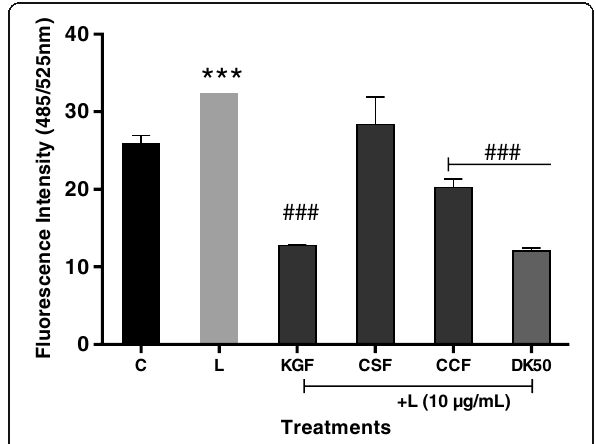
Fig. 2 Inhibition of LPS toxicity on U87 cell lines by various polysaccharide fractions and diclofenac potassium; ( a ) C-control cells; L-LPS (100 μ g/mL), KGF, CSF, CCF polysaccharides of Khaya grandifoliola stem bark, Cryptolepis sanguinolenta and Cymbopogon citratus leaves were tested at 100 μ g/mL and Diclofenac potassium at 50 μ g/mL (DK50). Data are expressed as mean±SEM, *** denote statistical signifi- cance p <0.001 in comparison to the control group; ( b ) KGF, CSF, CCF polysaccharides were tested at 12.5, 50 and 100 μ g/mL and DK50 #, ##, ### denote statistical significance at p <0.05, p <0.01 & p <0.001 in comparison to the LPS treated group